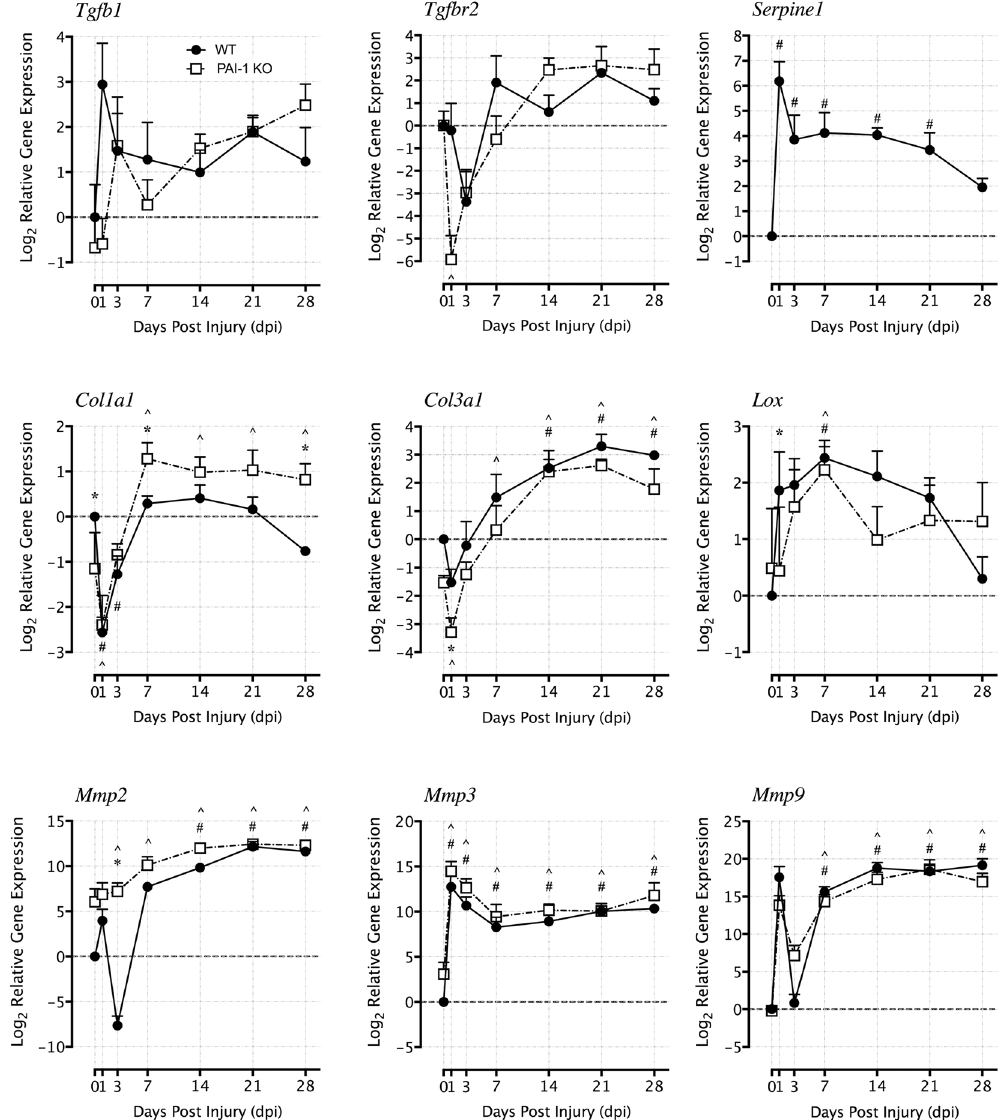
Figure 4. Loss of PAI-1 gene (Serpine1) in the KO flexor tendons led to early downregulation Tgfb1 & Tgfbr2 expression with no adverse effects on ECM gene expression and increased early expression of Mmp2 in comparison to injured WT flexor tendons. Gene expression analysis was performed at 1, 3, 7, 14, 21, and 28 dpi using rtPCR TaqMan Low Density Array (TLDA) designed for fibrosis-related genes. Gene expression levels were normalized to beta-actin as a house keeping gene and then plotted on a log 2 scale relative to day 1 gene expression levels in the WT flexor tendons. Data are expressed as mean ± standard deviation (SD). Asterisks ( * ) indicate significant differences between WT and PAI-1 KO (p < 0.05). Pound symbols ( # ) indicate significant differences between uninjured and injured in WT (p < 0.05). Caret symbols (^) indicate significant differences between uninjured and injured in PAI-1 KO (p <